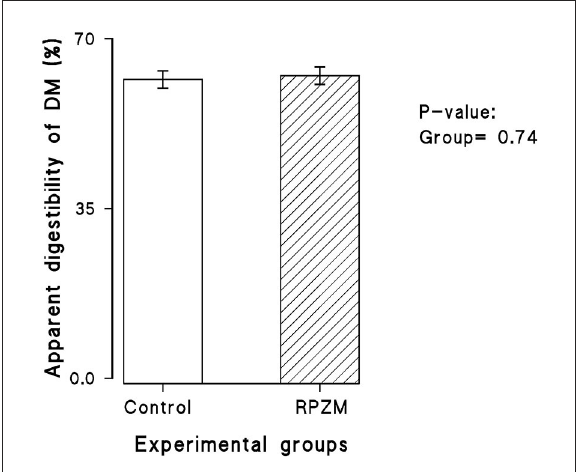
FIGURE2 Apparent digestibility of dry matter in high-producing Holstein cows supplemented without (control) or with